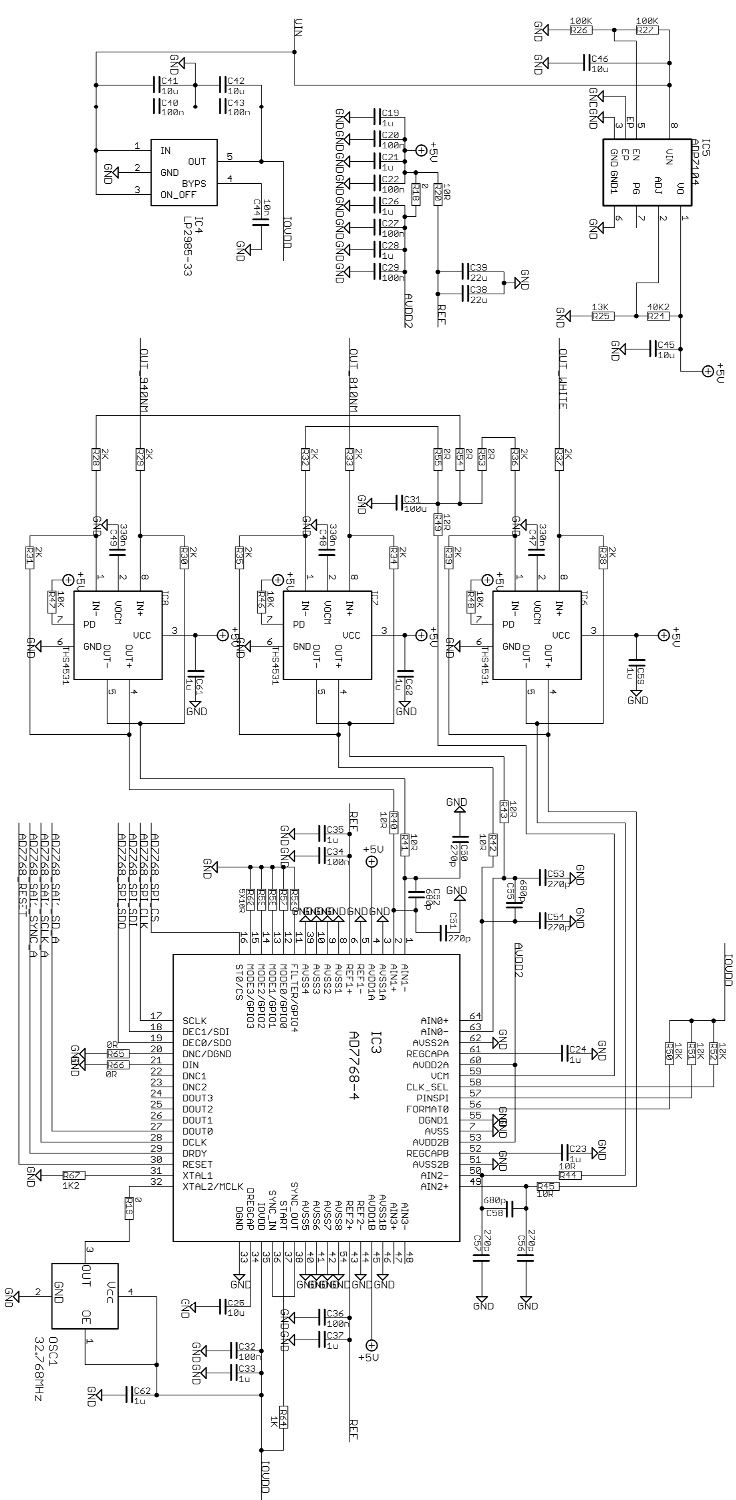
Figure A2. Three-channel ADC. The ADC is based on AD7768-4 (IC3) and converts the analogue audio signals to digital words. It is a four-channel 24-bit sigma delta ADC and we use the three of them. The three analog inputs of ADC are driven by three THS4531 differential amplifiers (ADC drivers). All functions of ADC (sampling rate, digital filtering, etc.) are controlled by the main CPU. The control interface is SPI and the digital audio data is transferred using the TDM protocol.